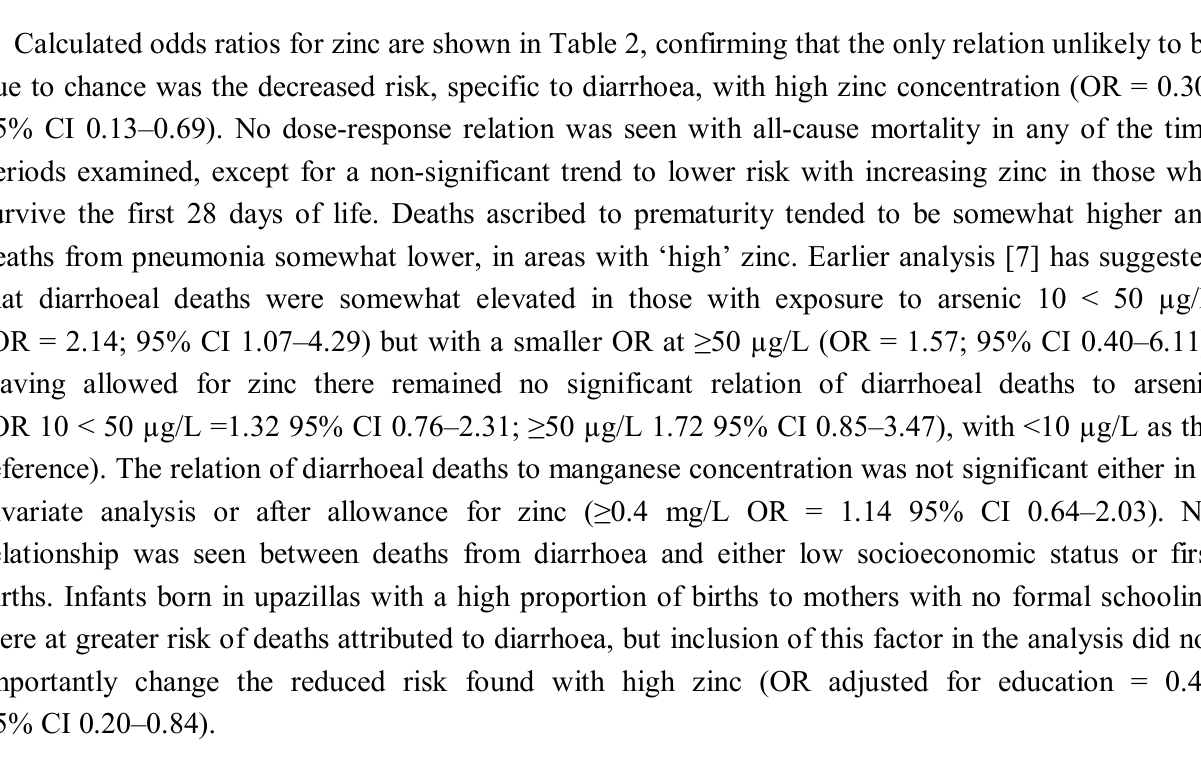
Table 2. Age and main causes of infant deaths over 2 years by mean well concentration of